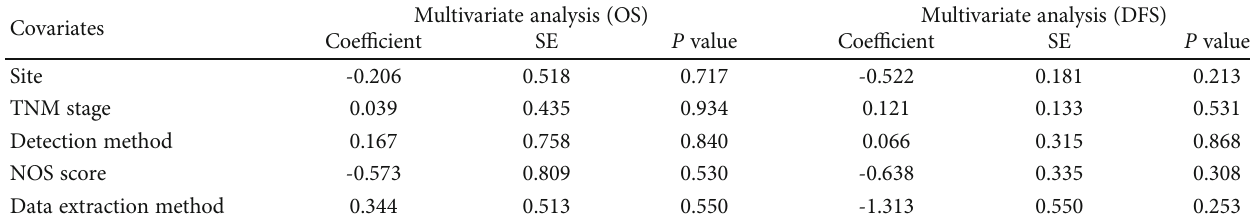
Table 3: Metaregression analysis for OS and